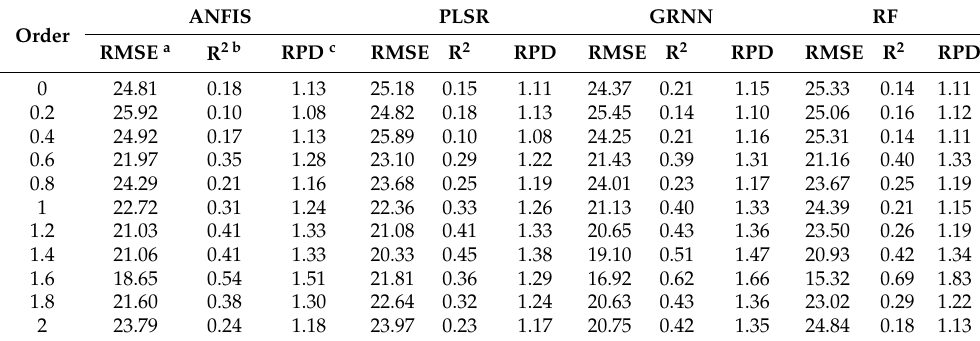
Table 6. Estimation model accuracy of